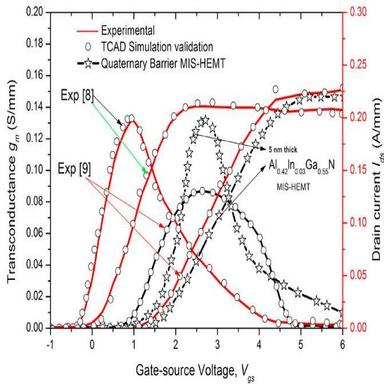
Shows the comparison of experimental and simulation of Ids-Vgs, transconductance and transfer characteristics for the device where the solid lines indicates the experimental and symbols indicates simulations curves respectively, for Vgs = −1 to 6 V. The experimental data and the simulation curve are matched with the device 5 nm Al0.42ln0.03Ga0.55N/UID-AIN/GaN/GaN MIS-HEMT.